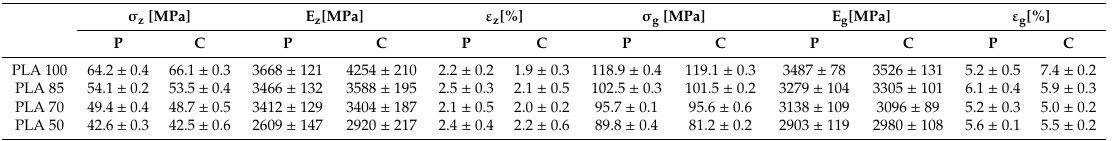
Table 3. Comparison of strength properties and Young modulus in neat and crystallized samples subjected to stretching and bending tests, P-Pure samples, C-crystallized